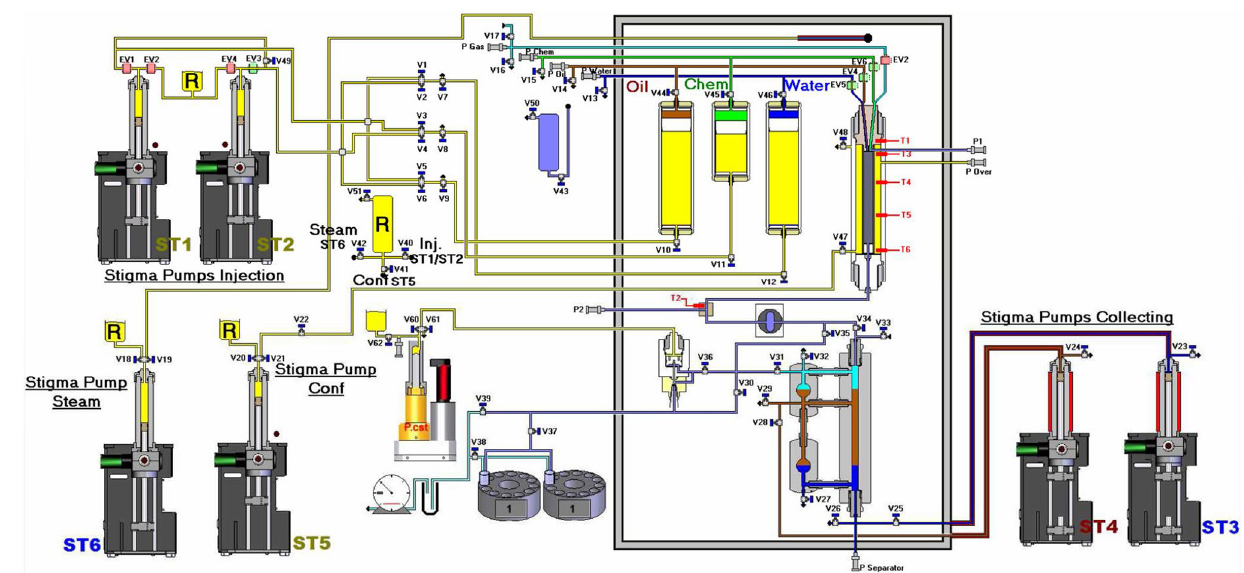
Fig. 10 Core flooding test schematic diagram (Sanchez